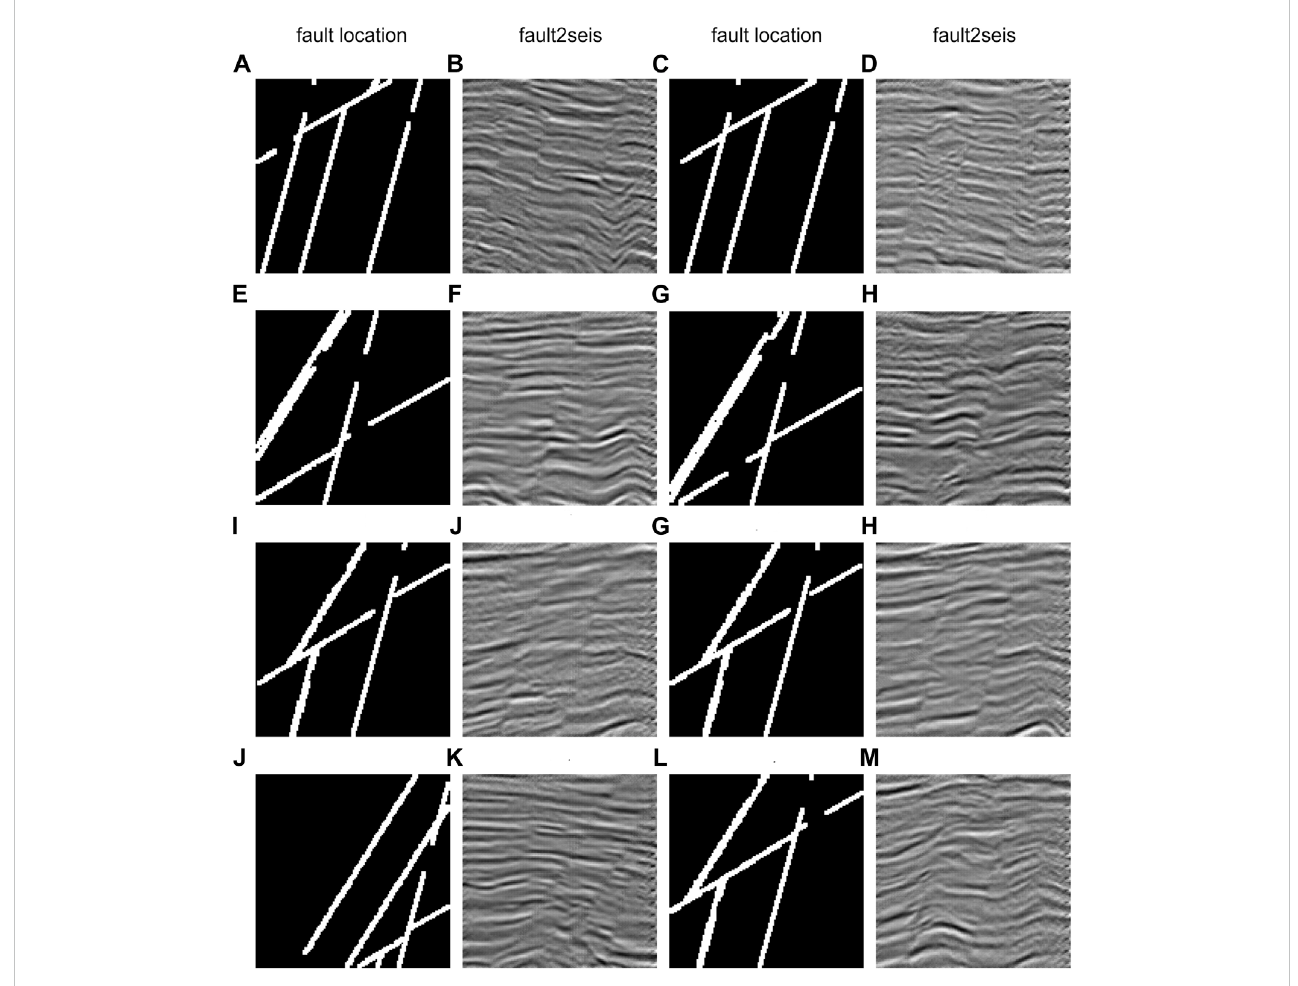
FIGURE 4 Random generation of fault locations (A, C, E, G, I, K, M, O) and the amplitude data generated by our model according to them. Although the generator can also produce some fold structures (B, F, J, N) , thedip angle of the formation is gentler than before (D, H, L, P) . Most fault locations correspond well to the amplitude data; only a few complex areas produce